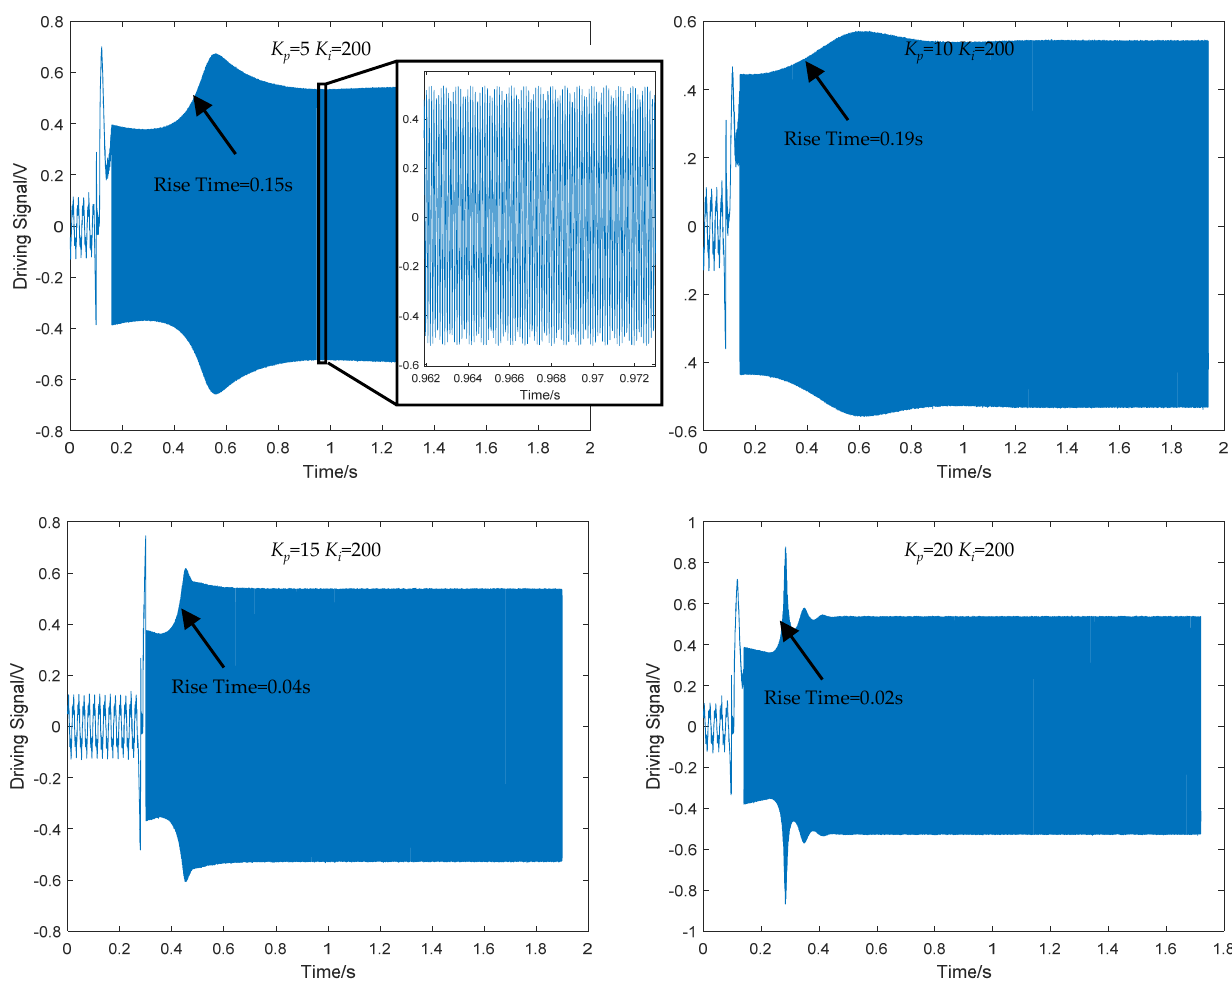
Figure 11. Transient response of PI parameters in closed-loop controlled drive loop.